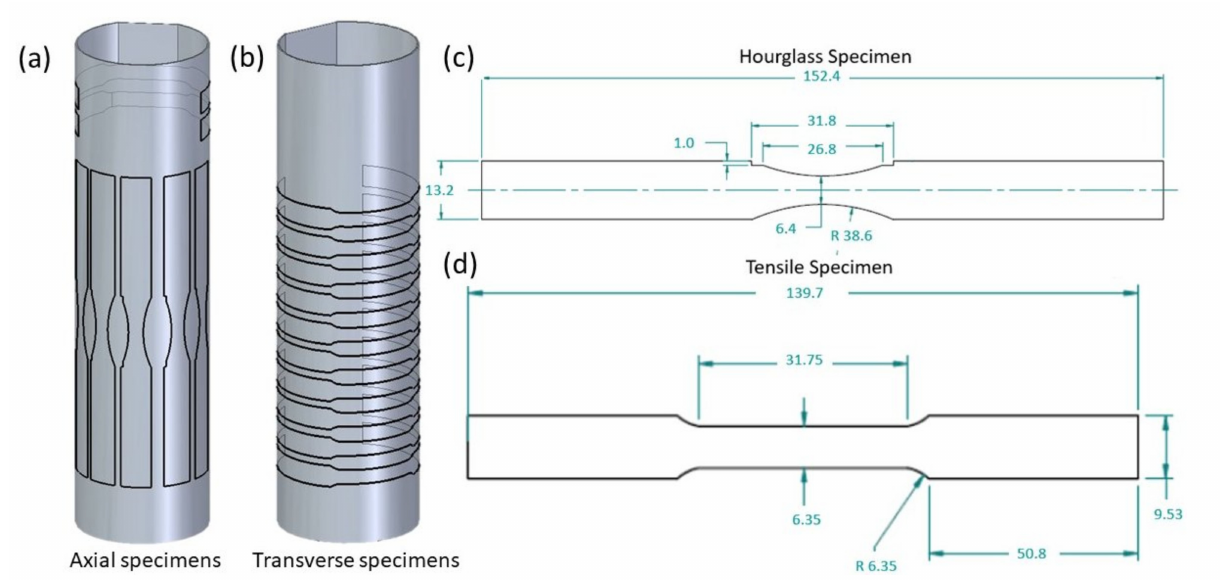
Figure 1. Drawings of tubes with cut plans for ( a ) axial specimens, ( b ) transverse specimens, ( c ) hourglass specimens (dimensions in mm), and ( d ) tensile specimen (dimensions in mm). Axial specimens had some minor curvature and were tested as machined, and transverse test specimens required flattening prior to test.